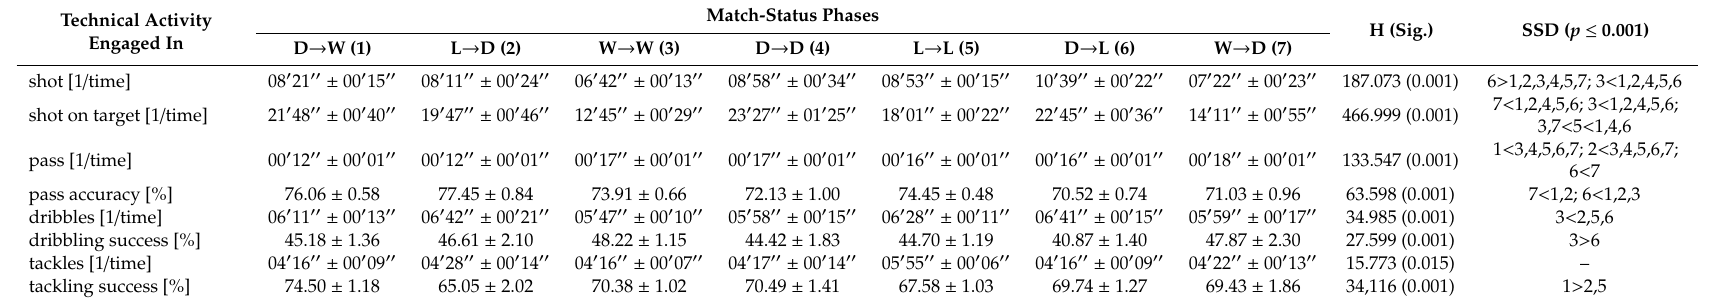
Table 2. Di ff erences in the frequency of occurrence of types of technical activity engaged in by soccer players with regard to match-status phases (mean ± SE). Technical Activity Engaged